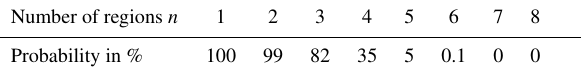
on eg i r e uden c P r